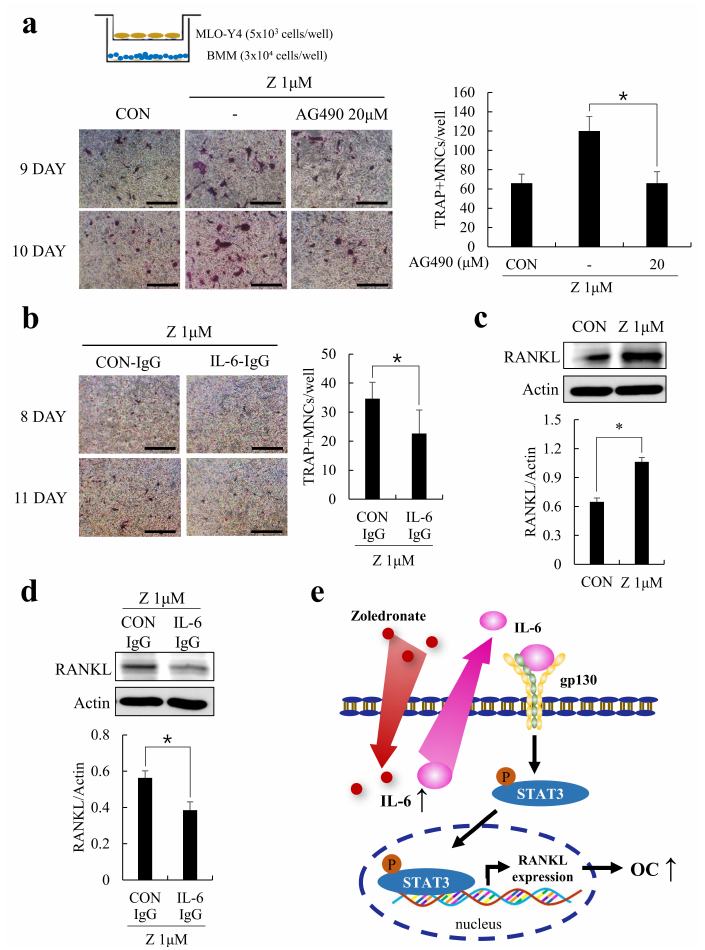
Figure 5. Zoledronate-induced upregulation of RANKL was reduced by AG490 or IL-6 neutralization. ( a ) MLO-Y4 cells were pretreated with the indicated combinations of zoledronate (1 µ M) or AG490 (20 µ